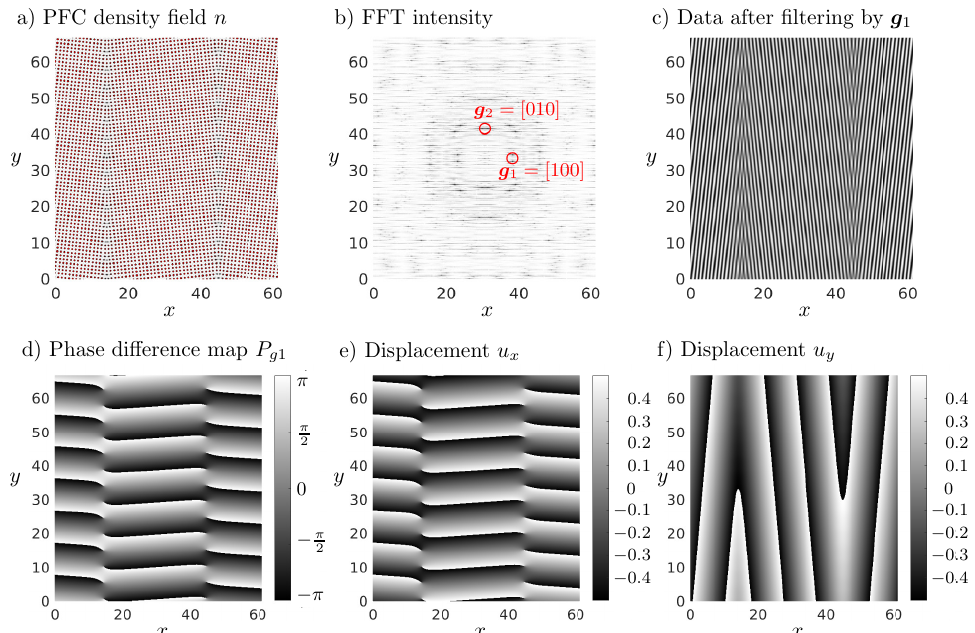
Figure 8. Steps in strain field evaluation using GPA based on PFC density field data: ( a ) Continuous PFC density field; ( b ) Intensity of the Fourier transform of the density field in a. Darker spots indicate high intensity peaks; ( c ) Result after masking the intensity at g 1 in Fourier space and then transforming it back to real space. The real part of the resulting complex map is shown; ( d ) Phase difference map evaluated according to Equation (26); ( e , f ) Displacement field components in the x- and y-directions, respectively, evaluated by Equation